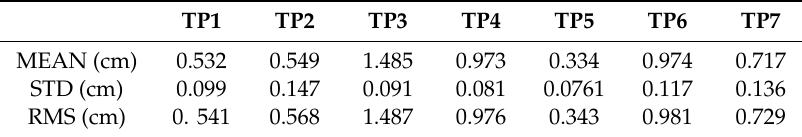
Figure 16. Statistical success rates as function of the sample interval. 0.5